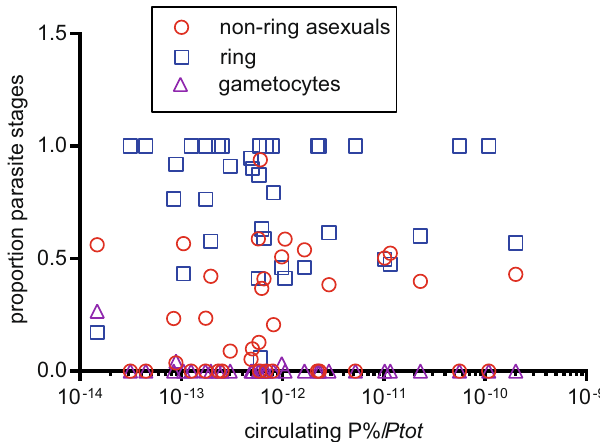
Fig. 2 | A relative measure of the proportion of total parasites that were cir- culating, i.e., the ratio of circulating parasitemia/calculated total parasite biomass(Ptot)doesnotcorrelatewithproportionsofcirculatingringstageor asexual, non-ring stage parasites. Circulating parasitemia/Ptot from 37 malaria patient samples 1 plotted against the proportion of gametocytes, asexual non-ring stage parasites and ring stage parasites estimated by our mixture model from the parasite transcriptomes of each sample 1 . Source data are provided as a Source Data fi